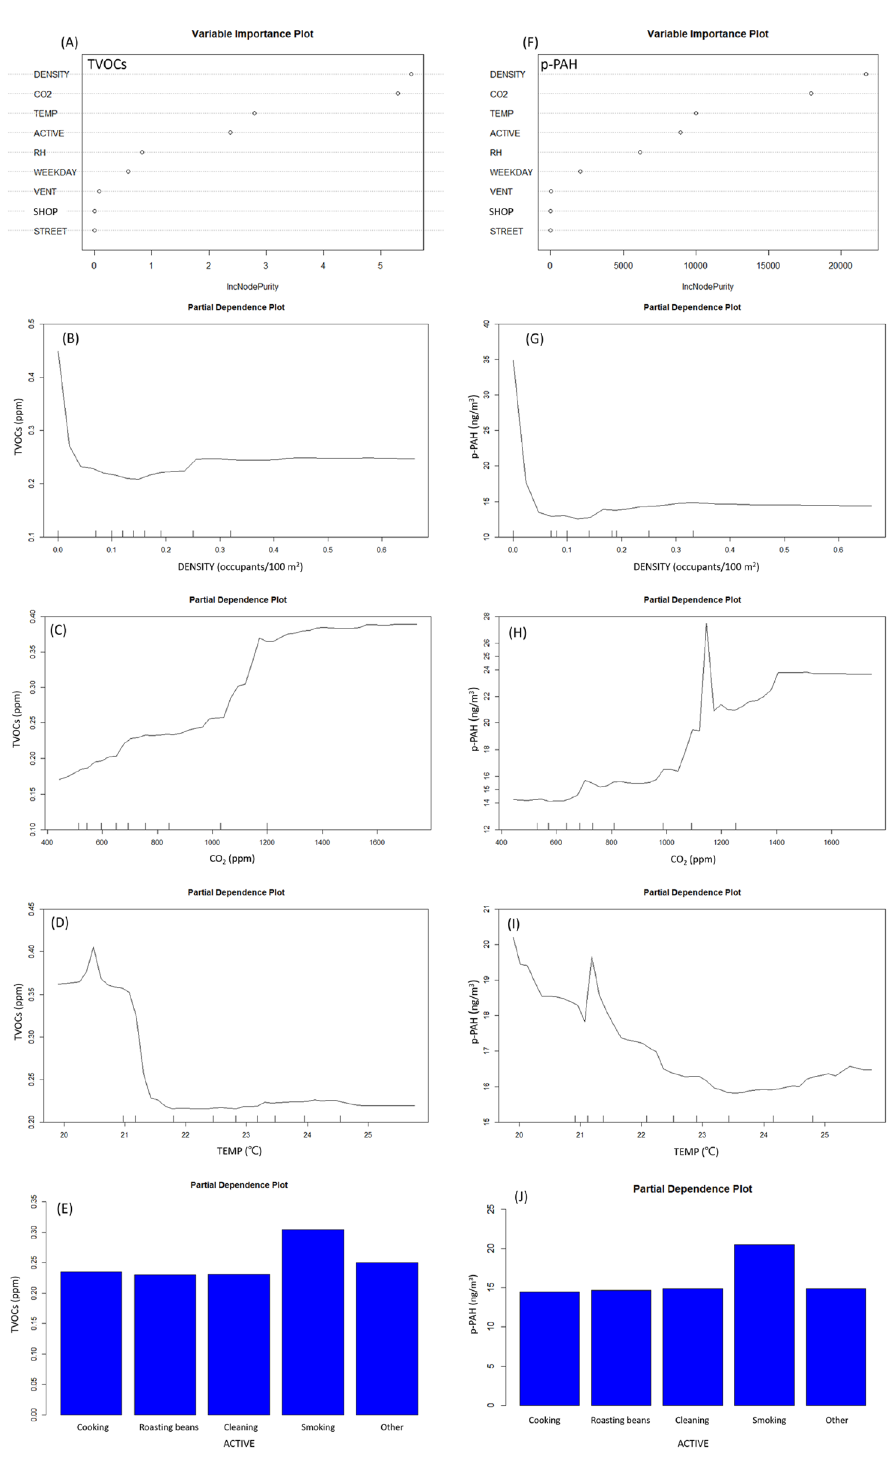
Figure 4. Variable importance rank and partial dependence plot of total volatile organic compounds (TVOCs) and particle-bound polycyclic aromatic hydrocarbons (p-PAHs) from Random Forests models. (ACTIVE, Indoor activities; CO 2 , carbon dioxide (ppm); DENSITY, Occupant density (person/m 2 ); RH, relative humidity (%); SHOP, coffee shop A, B, C, D; STREET, locating on the main traffic street; TEMP, temperature(°C); VENT, ventilation